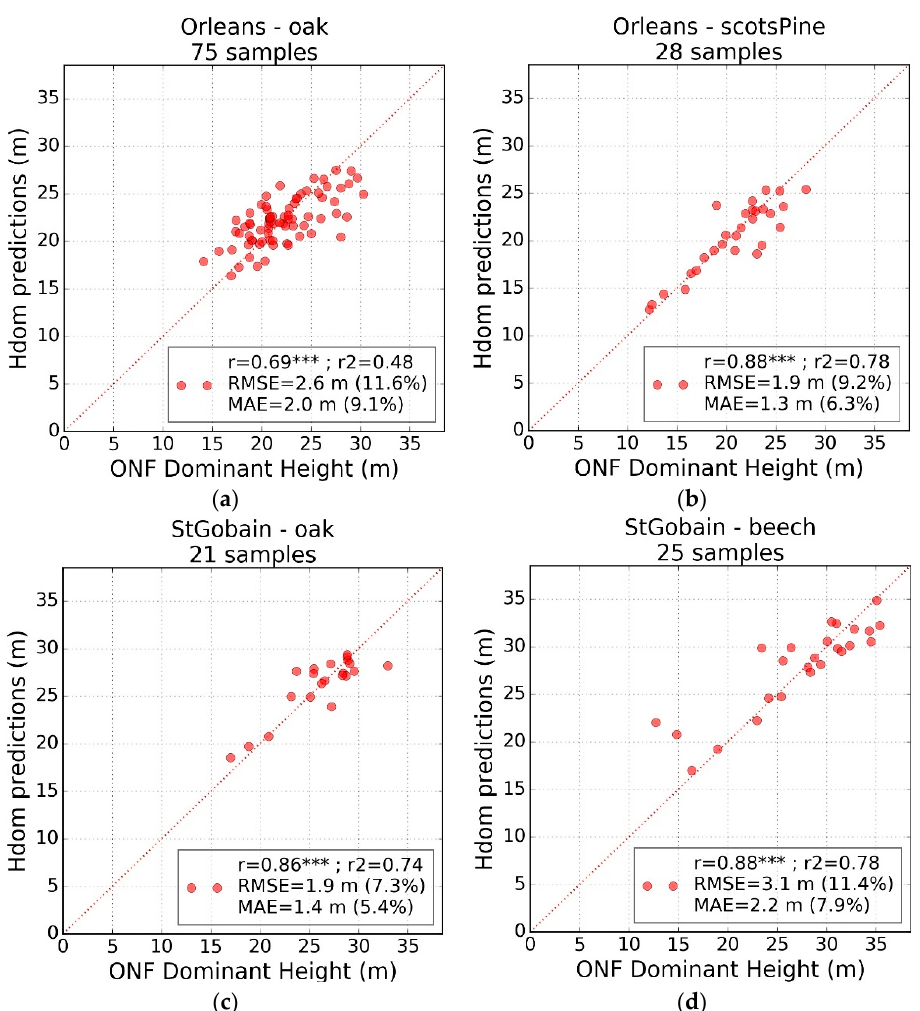
Figure 5. Validation scatterplot of dominant height (Hdom) estimations with the processing